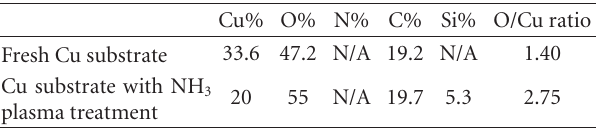
Figure 3: PCR as a function of SiN x deposition counts on di ff er- ent substrates performed at PRODUCER SE 300 mm twin PECVD deposition system. Table 1: Surface composition (atomic percentage) of fresh Cu sub- strate and Cu substrate with NH 3 plasma treatment.